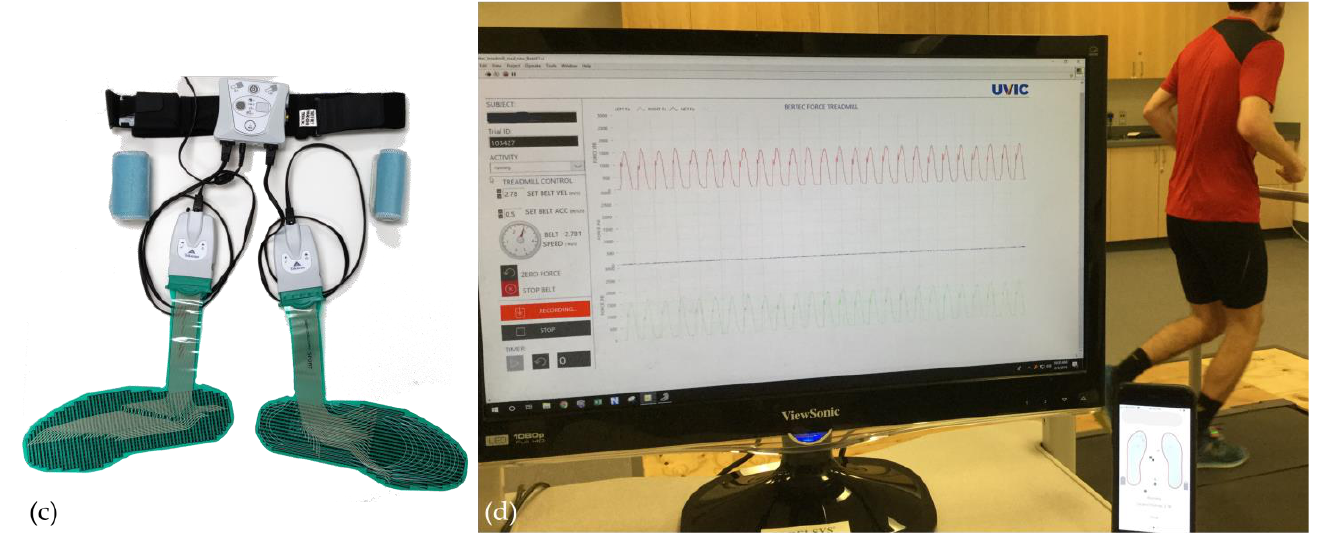
Figure 2. Part 1 testing equipment: ( a ) linear force testing device with 30 mm diameter actuator disk and force plate used for the sinusoidal testing ( b ) pneumatic bladder pressure tester used for step test, static test, and reliability test ( c ) Tekscan F-scan system. Part 2 testing equipment: ( d ) Bertec force-instrumented treadmill.